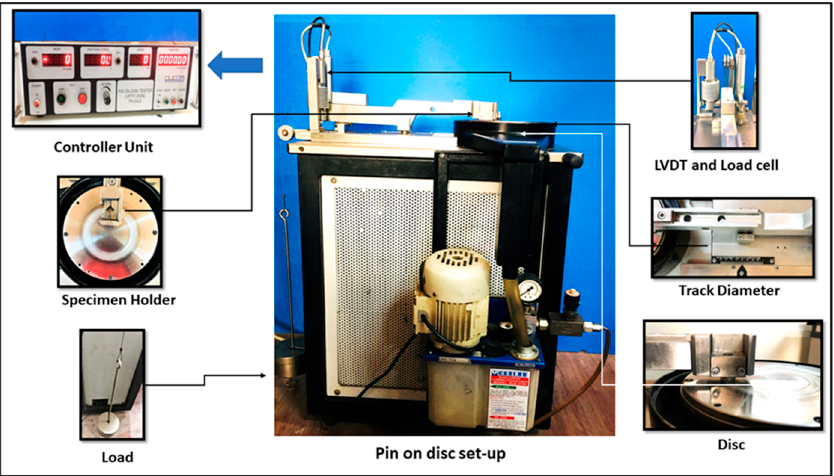
Figure 2. Pin-on-disc wear test setup.